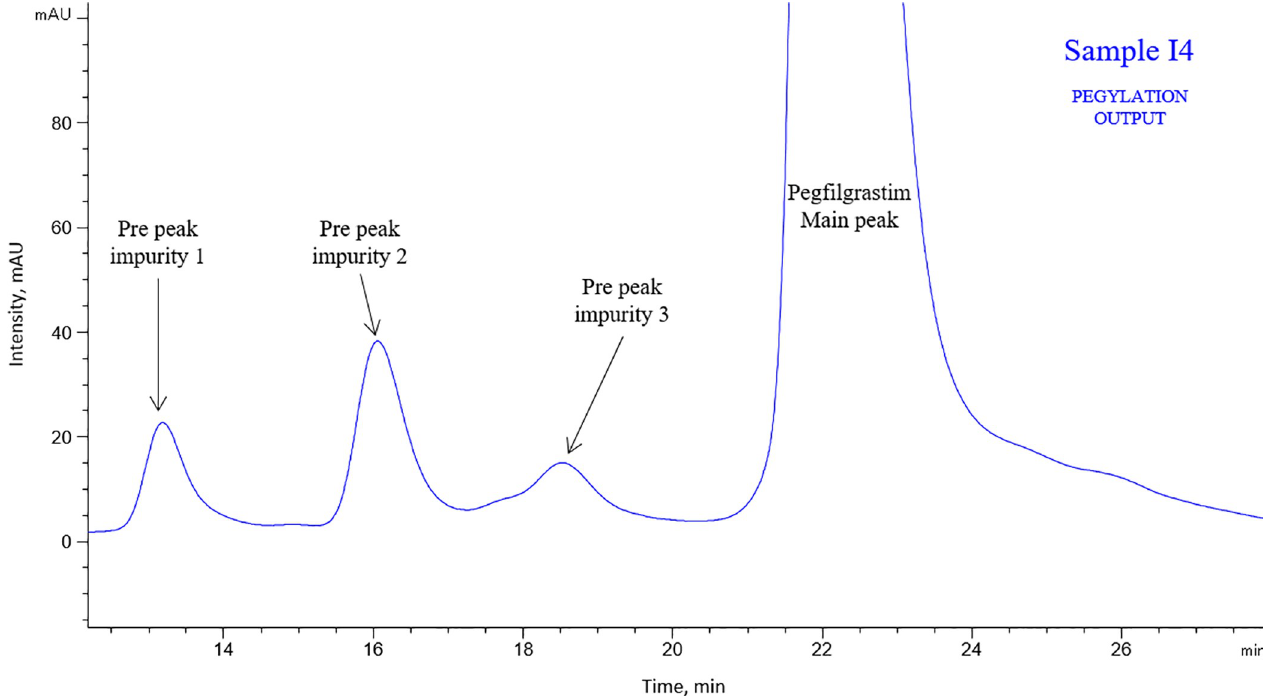
Fig 8. Representative CEx-HPLC profile of POP Sample I4 showing Pre-peak impurity 1 (RRT 0.60), Pre-peak impurity 2 (RRT 0.73) and Pre-peak impurity 3 (RRT 0.84).